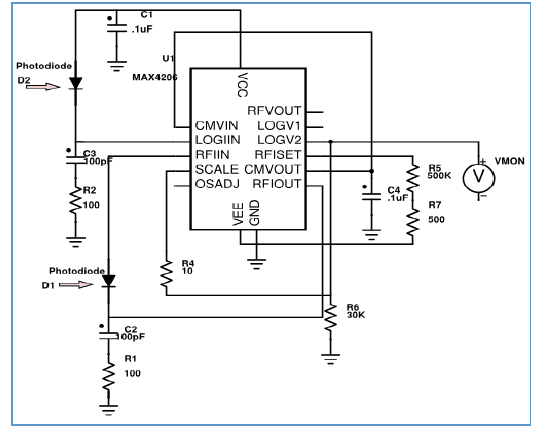
Figure 5. Photodiode amplifier circuit based on transimpedance ampli- fier.